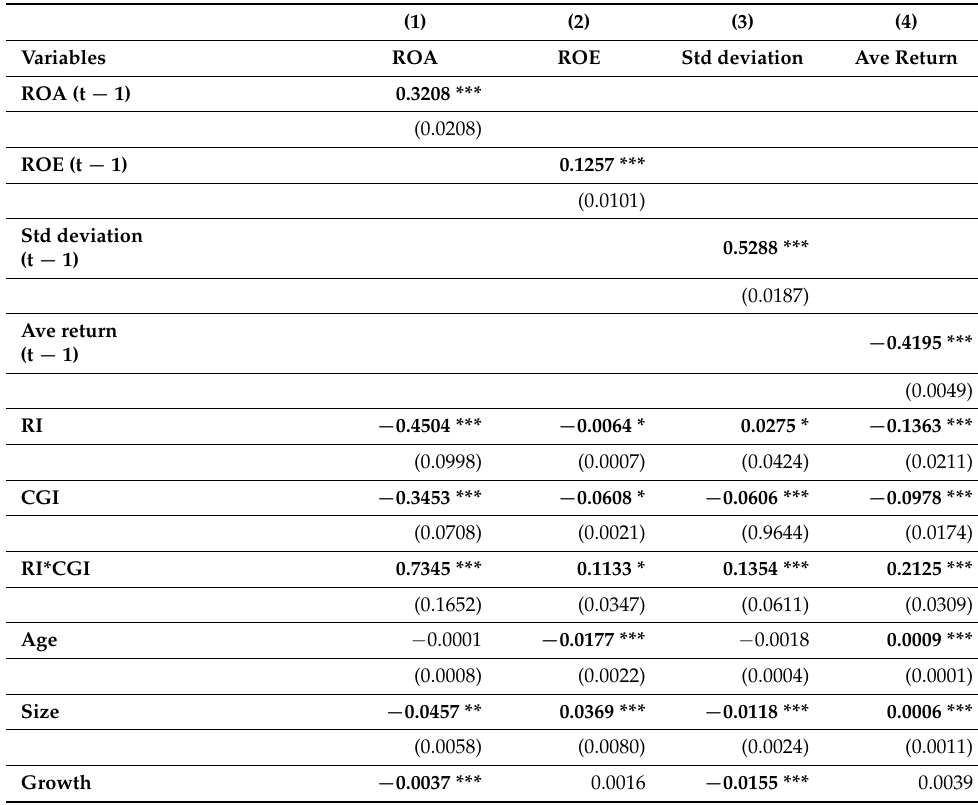
Figure 1. Panel plot of Risk Index and Age of the companies across various sectors with CGI as the size parameter over time. Table 6. Additional analysis and tests of